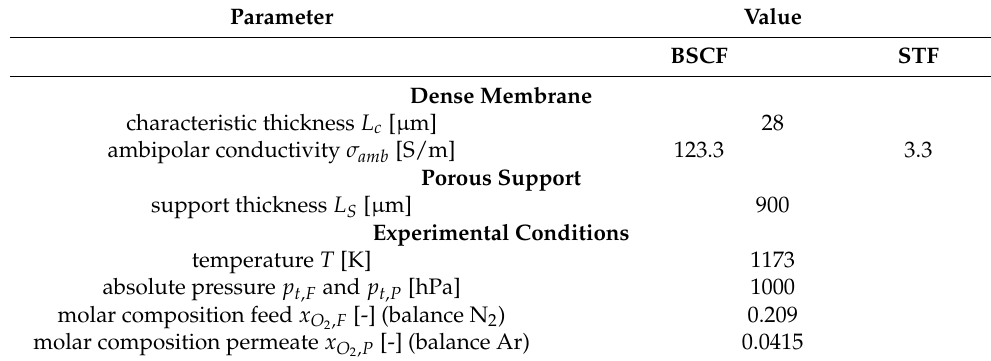
Table 1. Material and experimental parameters used for all calculations in this study.